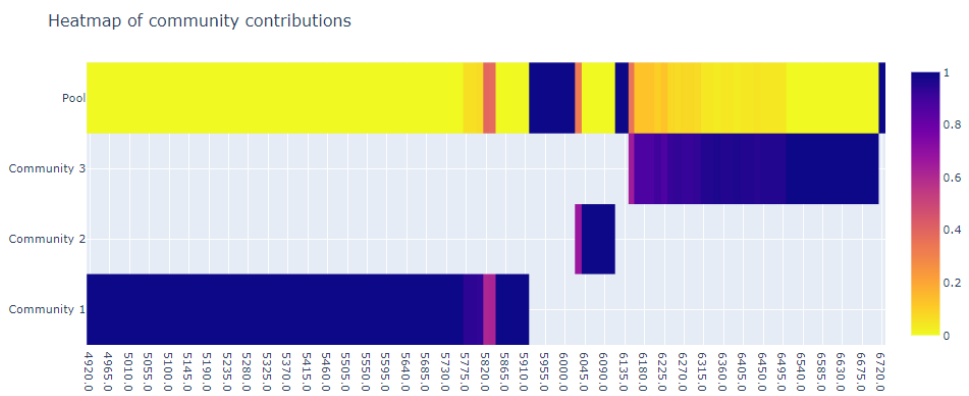
Figure 19. Complex communities for the first time window without regulations.